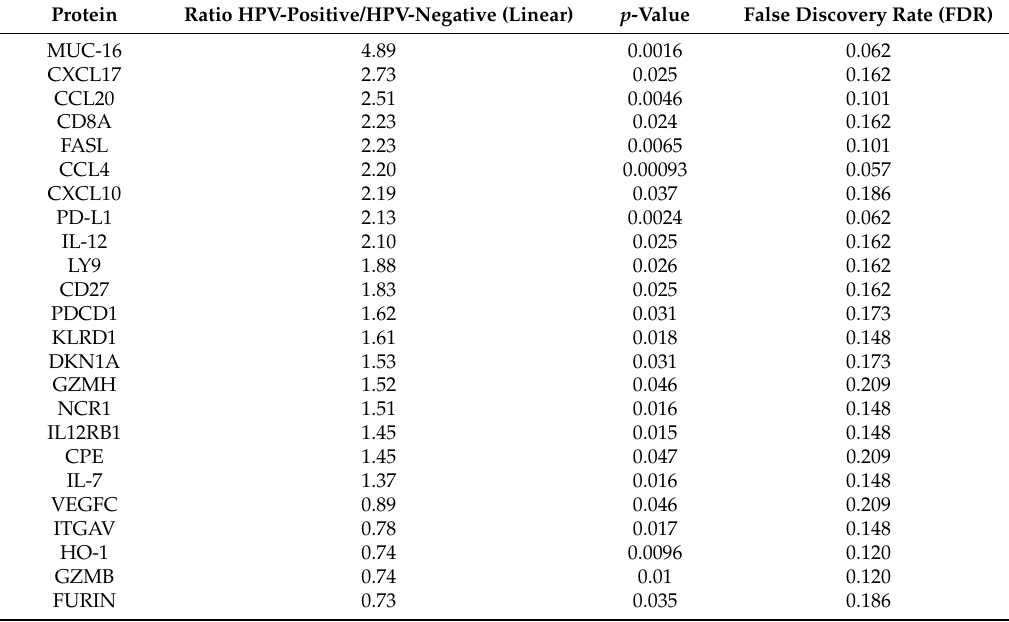
Table 3. Protein with significant differences in expression between HPV positive and negative TSCC and